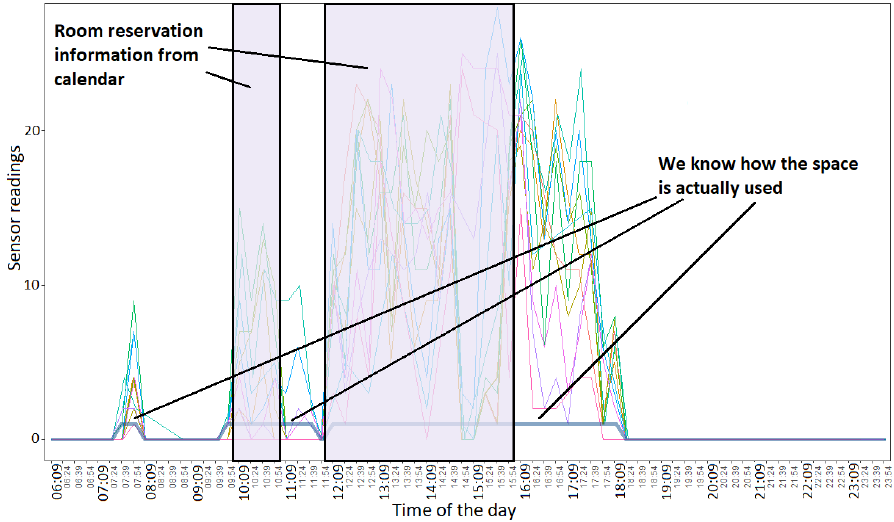
Figure 7. Visualization of the motion and calendar data in particular day in Aspire